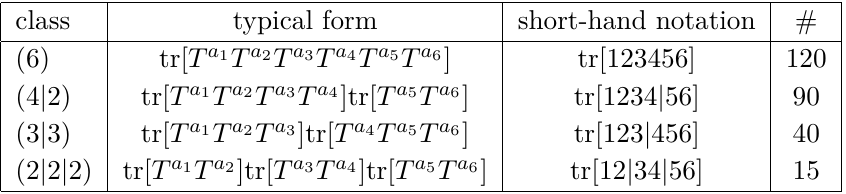
Table 4 . Flavor factors for 6-pt amplitudes for SU( N f ≥ 6) . For N f < 6 additional redundancy relations appear, as explained in section 3 and summarized in table